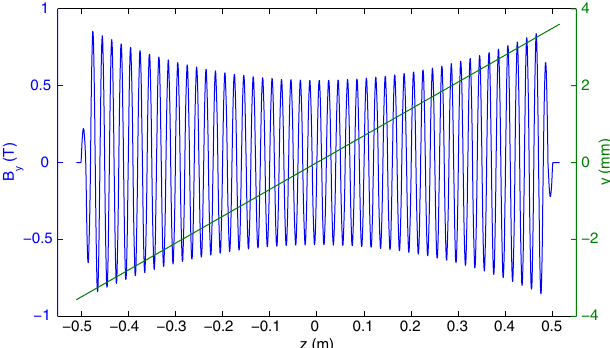
FIG. 7. An example of a vertical trajectory in a planar undu- lator and the magnetic field as seen by the particle. The angular offset is taken to be rather large to illustrate the effect of cosh- like dependence of the field on vertical